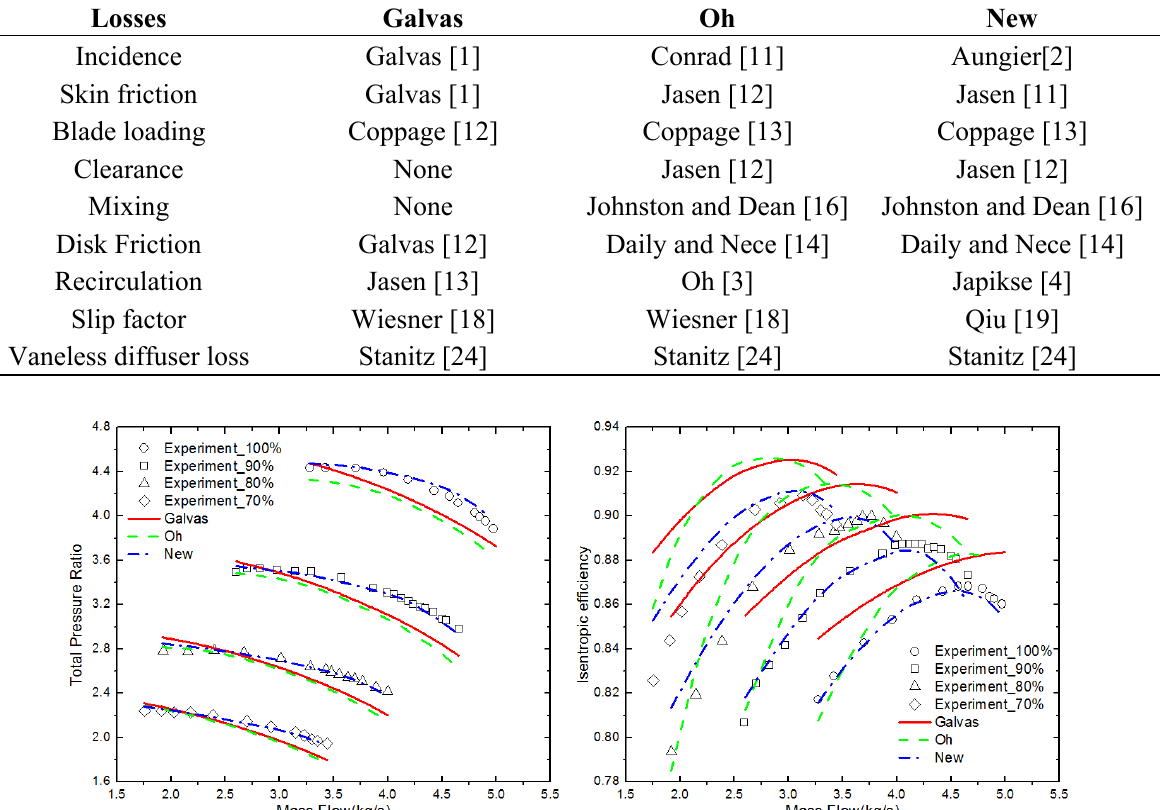
Table 2. Loss model combination.